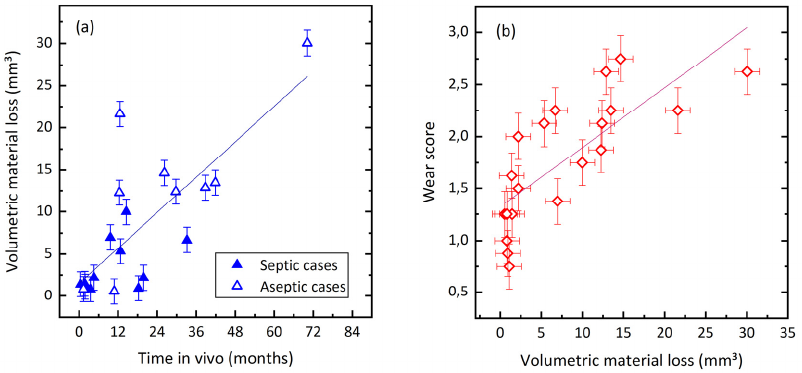
Figure 8. ( a ) Volumetric material loss increases with time in vivo. ( b ) Relationship between wear score and volumetric material loss.